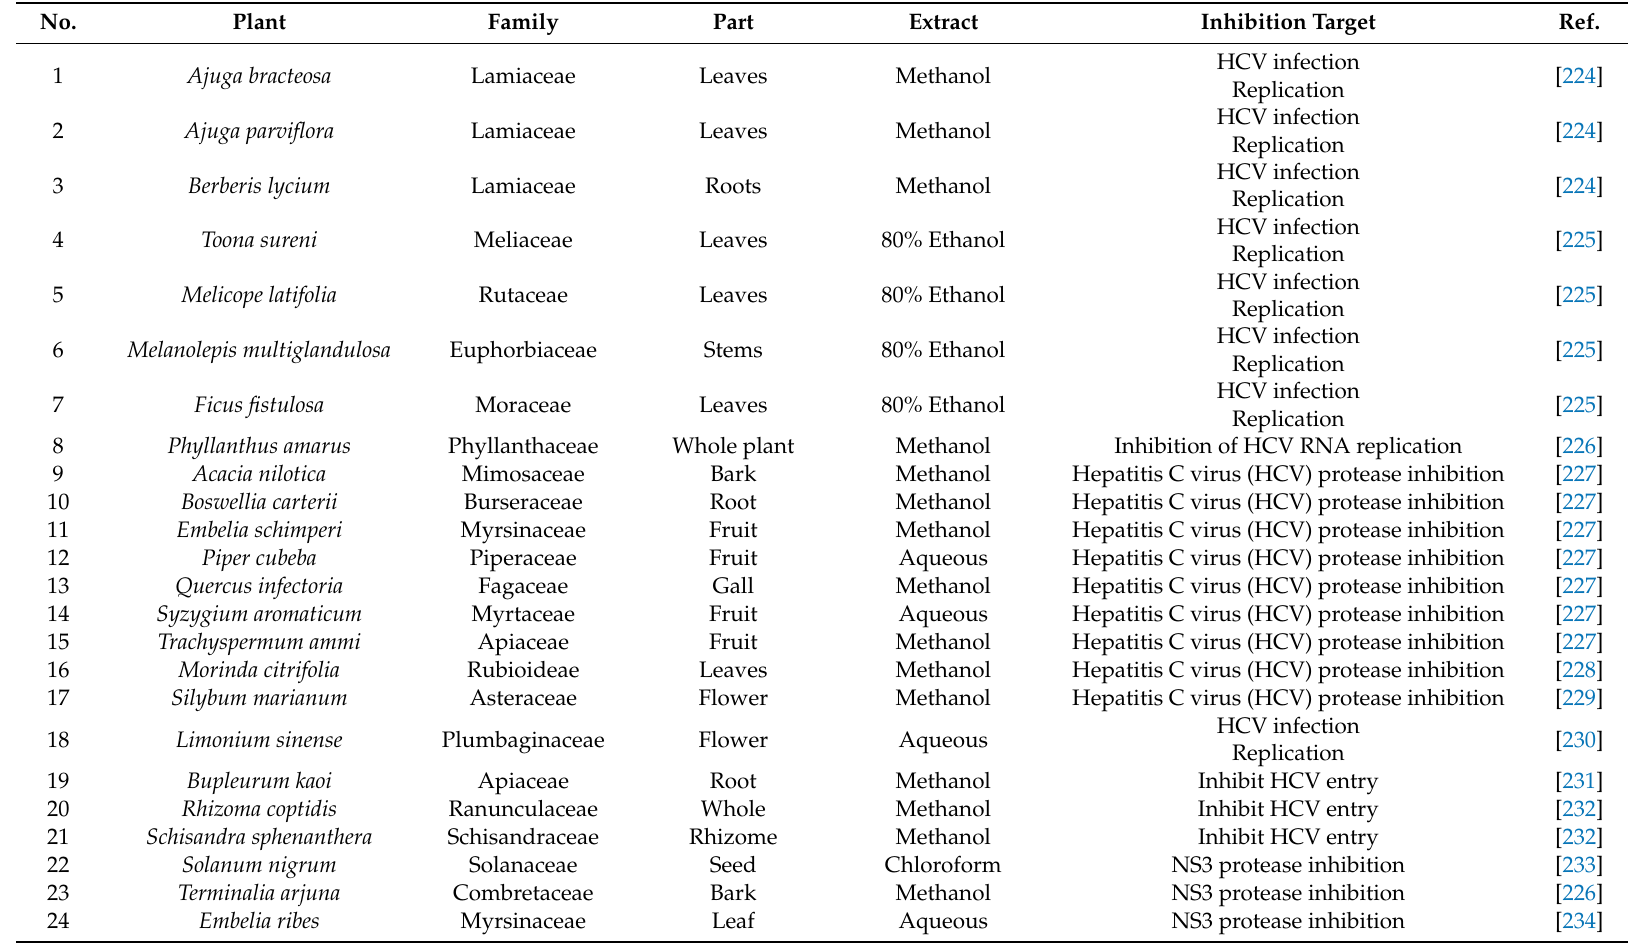
Table 7. Review of the plants that have shown anti-HCV activities with their prospective family, part, type of extract, and inhibition target. No.